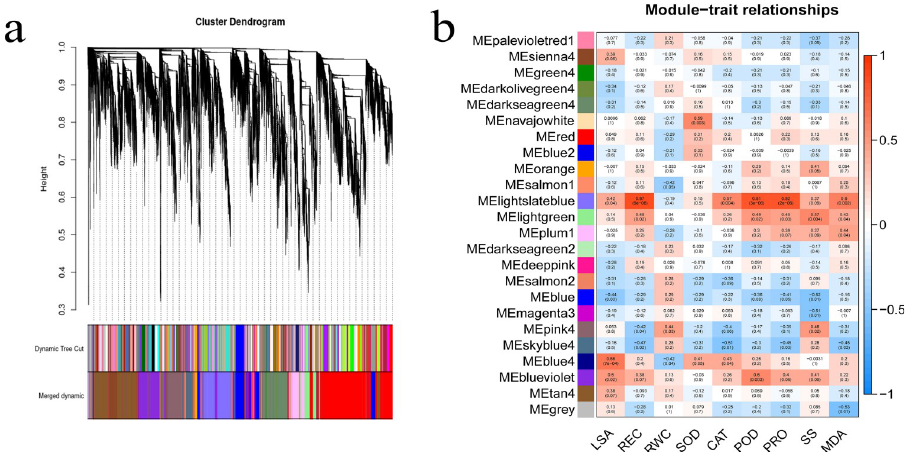
Fig 8. WGCNA co-expression network and module-trait correlation analysis. (a) Hierarchical cluster tree showing co-expression modules identified by the Dynamic Tree Cut method. Each leaf, that is a short vertical line, corresponds to a gene. Branches of the dendrogram group together densely interconnected constitute modules and are labeled with different colors. Genes with highly co-expression level (correlation � 0. 75) were merged to one module, 24 modules were obtained in total. (b) Correlations of physiological traits with WGCNA modules. Each row corresponds to a module The columns correspond to nine physiological traits. The color of each cell indicates the correlation coefficient between the module and traits, Red represents positive correlation and blue represents negative correlation. (The top number in the cell represents the correlation coefficient, and bottom one in parentheses represents the P value).